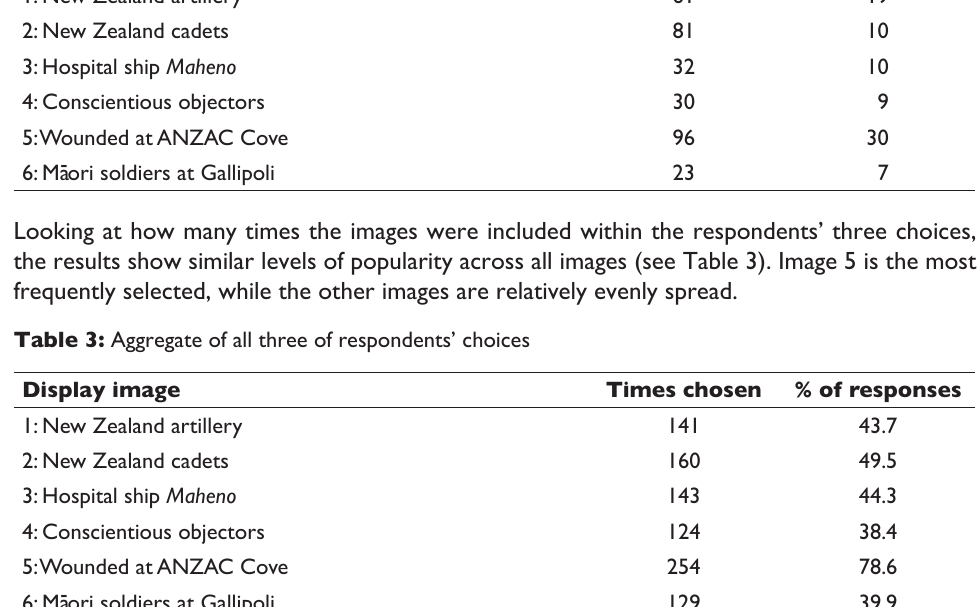
Table 2: Respondents’firstchoices Display image